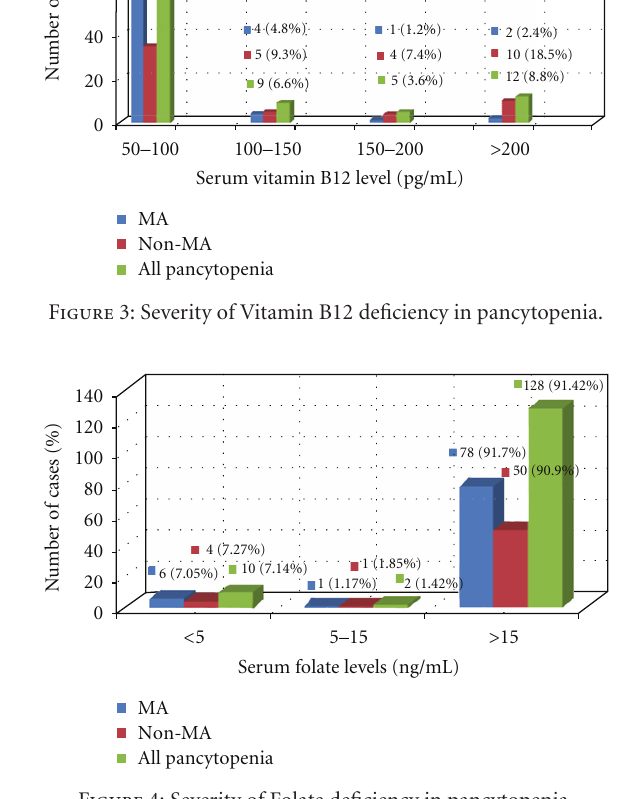
Figure 4: Severity of Folate deficiency in